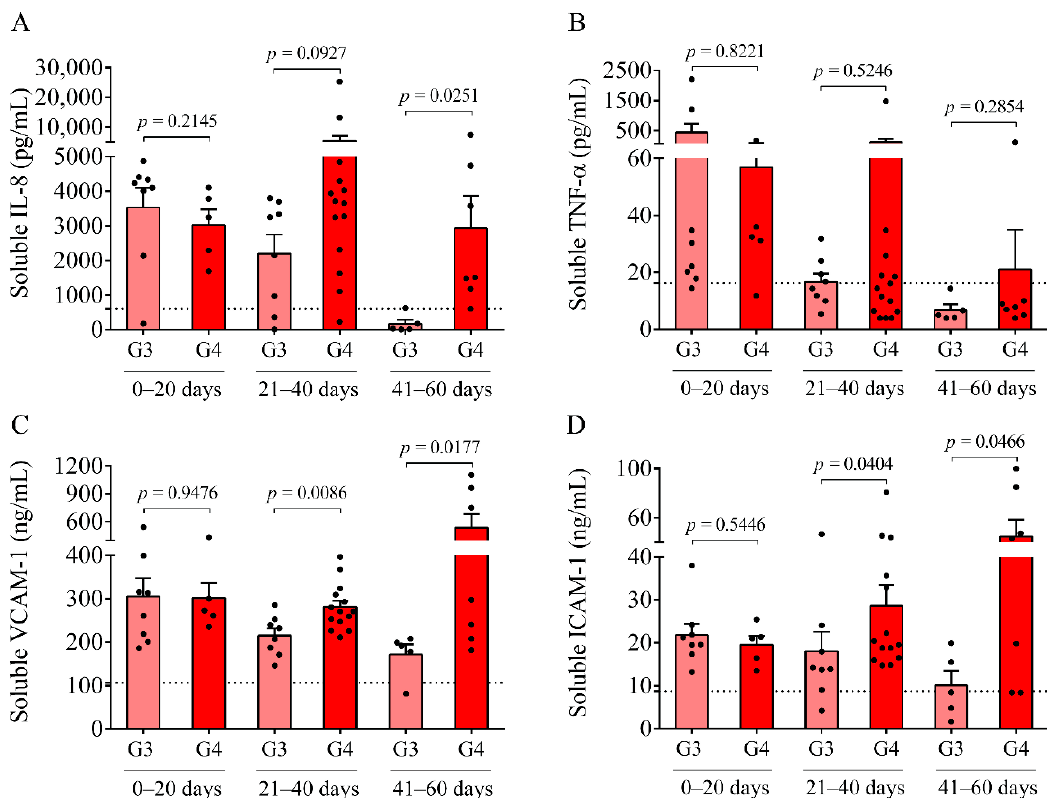
Figure 3. Measurement of soluble pro-inflammatory protein biomarkers in post-IVH CSF samples. Soluble IL-8 ( A ), TNF- α ( B ), VCAM-1 ( C ), and ICAM-1 ( D ) concentrations in IVH-III (G3, light red) were the highest in the CSF samples obtained between 0 and 20 days after the onset of IVH and showed a time-dependent decrease in the following intervals. The level of these markers remained elevated and even higher soluble IL-8 ( A ), VCAM-1 ( C ), and ICAM-1 ( D ) values were measured in IVH-IV (G4, red) CSF compared to the IVH-III at days 41–60. Dots represent single results. Mean ± SEM are depicted. Dotted lines depict the mean value of the particular parameter measured in preterm non-IVH control samples [23]. To compare the data of the two groups, the Mann–Whitney U test or unpaired t -test was applied. Abbreviations: CSF, cerebrospinal fluid; G3, Grade-III IVH; G4, Grade-IV IVH; ICAM-1, intercellular adhesion molecule 1; IL-8, interleukin-8; IVH, intraventricular hemorrhage; TNF- α , tumor necrosis factor alpha; and VCAM-1, vascular cell adhesion molecule 1.